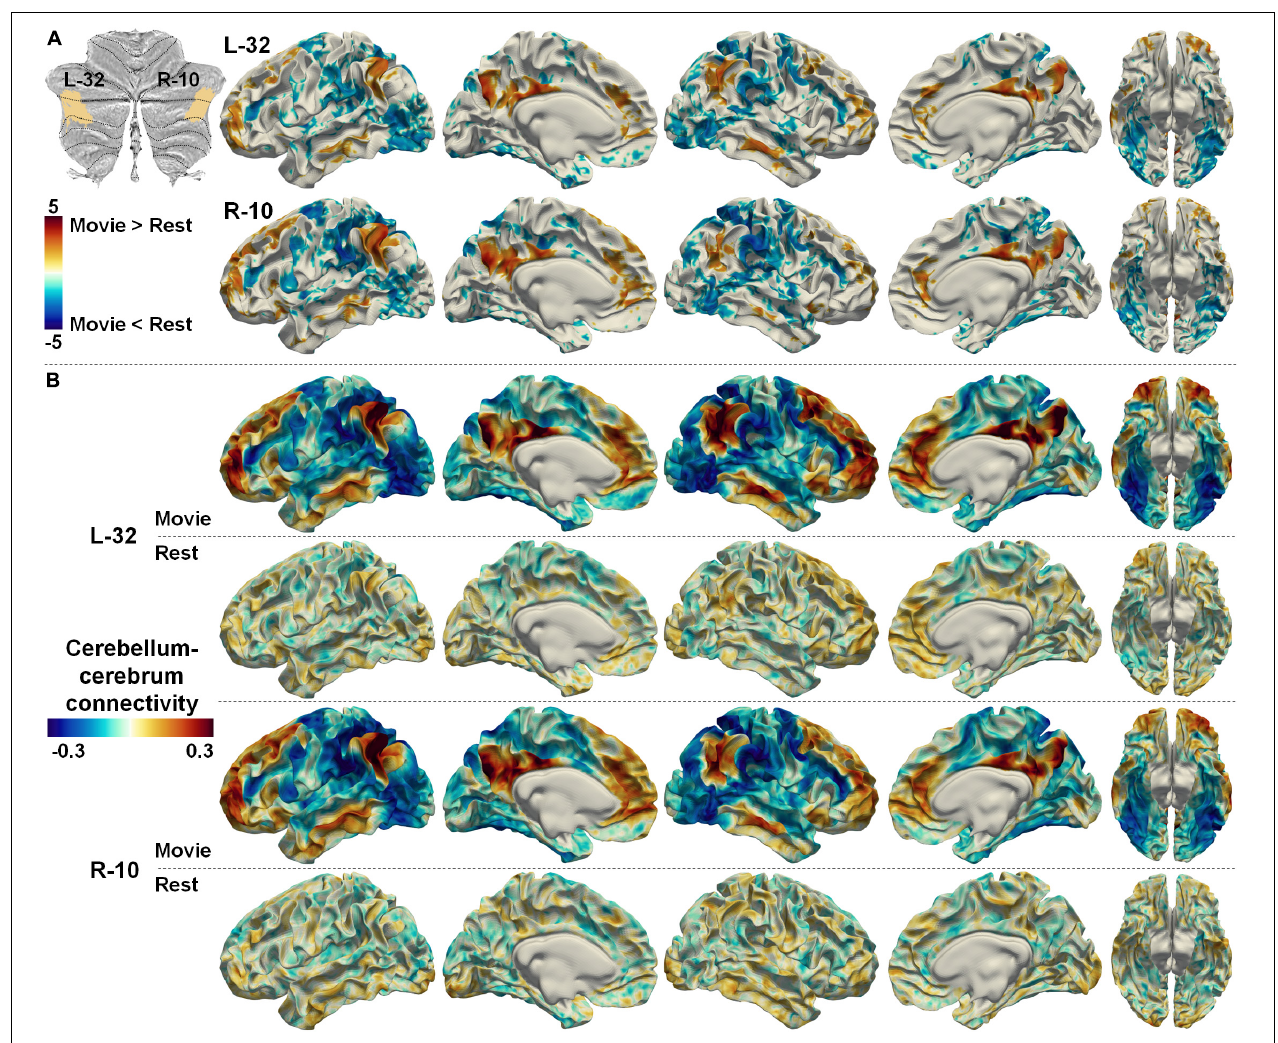
FIGURE 9 | (A) The difference between cerebellum–cerebrum connectivities in nfMRI and rsfMRI for two symmetrical regions (L-32 and R-10, related to the DMN) in the Movie 64 parcellations. (B) The strength of cerebellum–cerebrum connectivities for the two regions in nfMRI and rsfMRI.